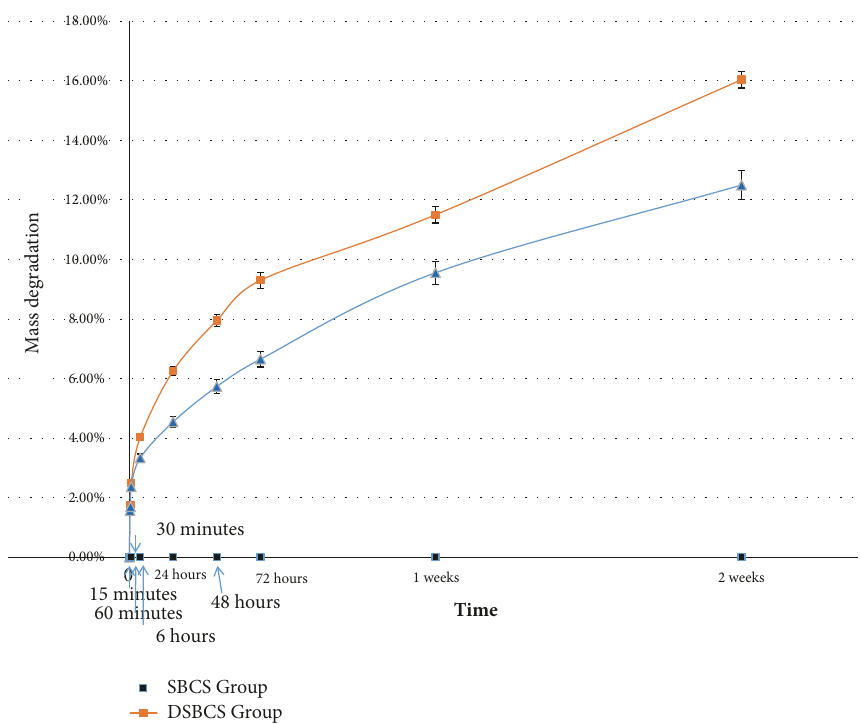
Figure 5: Plot of biodegradation of both sponge bovine cartilage scaffold groups at 15, 30, 60 minutes, 6, 24, 48, 72 hours, 1 and 2 weeks. The error bars represent the standard deviation of measurements for 9 points of time in 6 separate sample runs (n = 54) in each scaffold group.